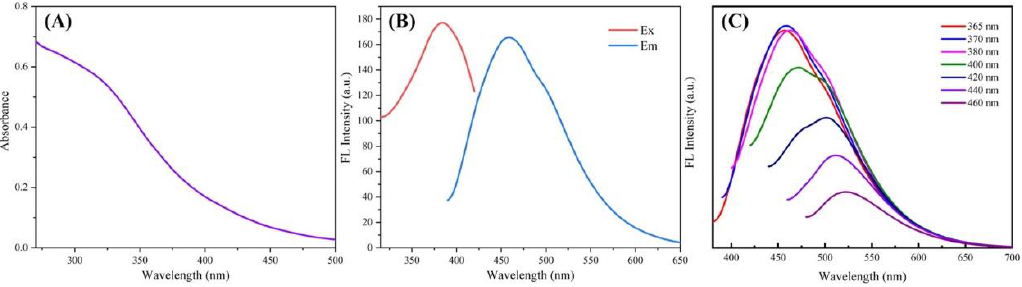
Figure 2. ( A ) UV/vis absorption spectrum of L-CDs; ( B ) The emission (blue line) and the excitation (red line) spectra of L-CDs; ( C ) fluorescence spectra of L-CDs with different excitations (from 365 to 460 nm).